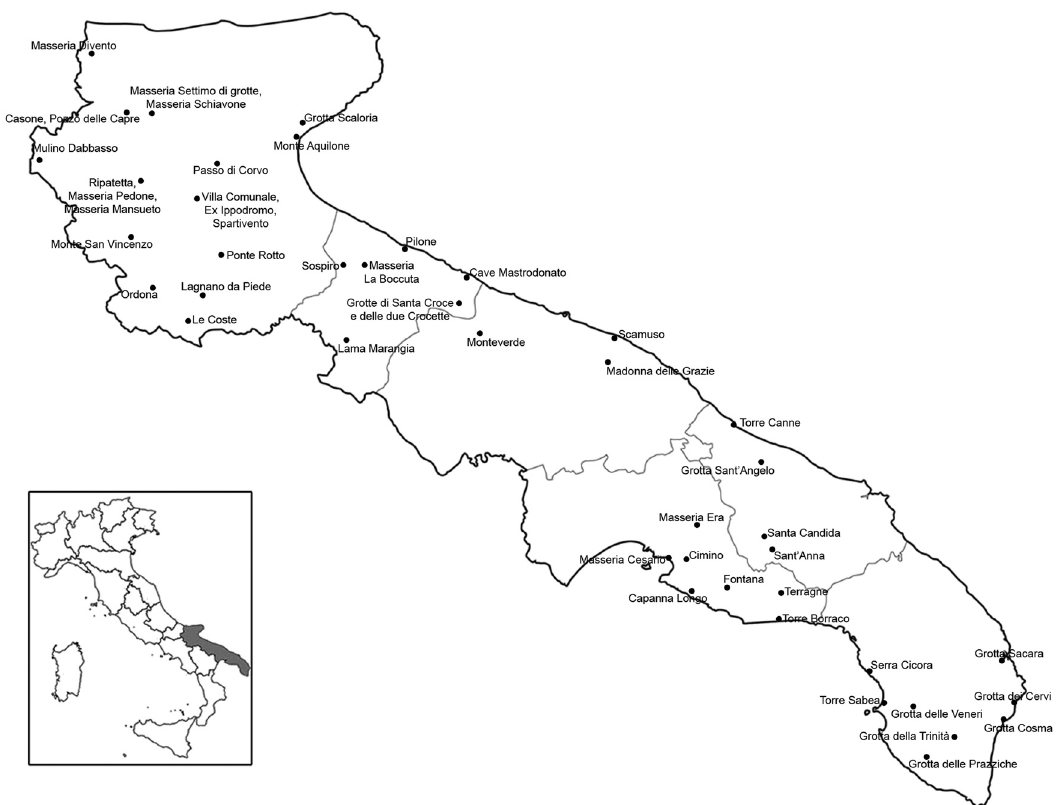
Figure 5: Location of the sites mentioned in the